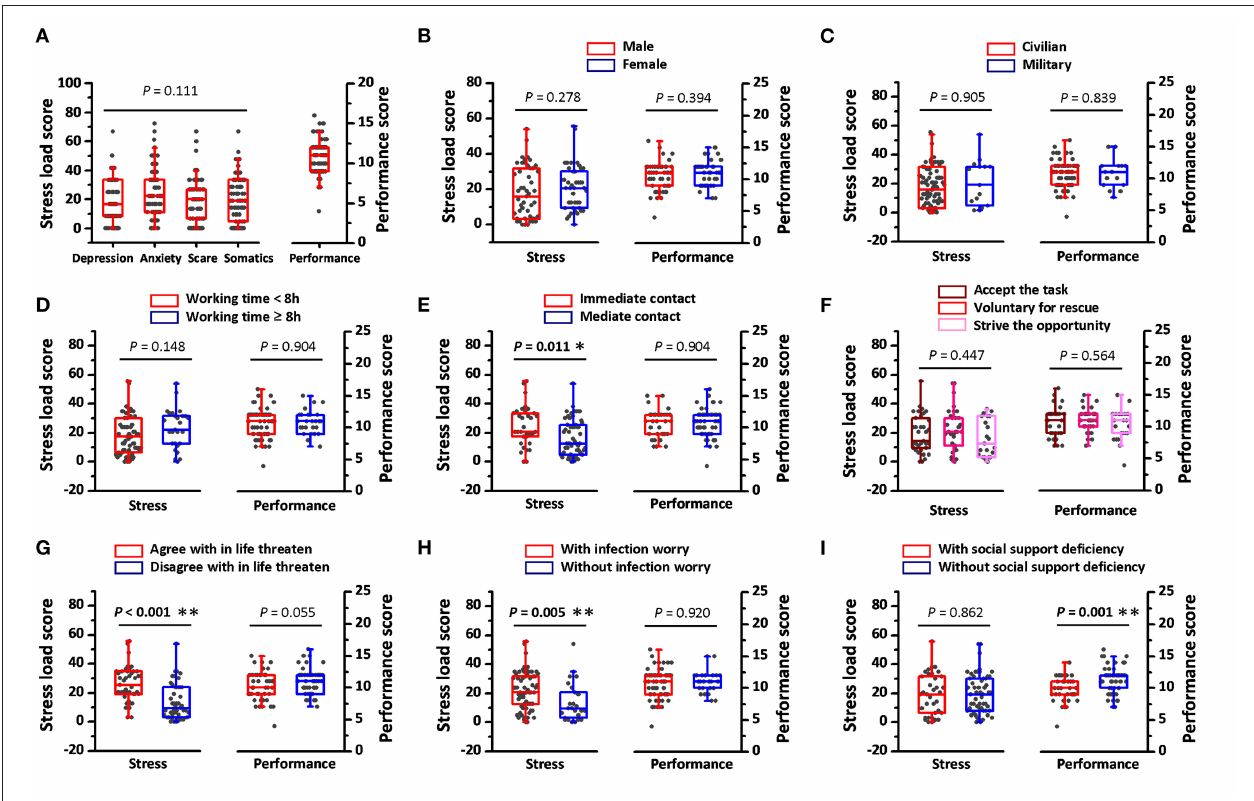
FIGURE 1 | Stress load and working performance assessment in Wuhan medical rescuers. (A) The stress load score of all survey participants in depression, anxiety, scare, and somatic alteration dimensions. The stress load score in each dimension was calculated as a normalized ( × 100 to make it from 0 to 100) ratio between items total scores to possible max scores in the respective dimension. Performance scores, calculated as the summation of four items scores, were also presented to show the performance in all survey participants. (B–I) The stress load scores and performance scores in different genders, identities, working time per day, COVID-19 contacts, motives for joining rescue, subjective views, and social supports. The general stress load scores were calculated as the average among the scores in the four dimensions. Social support deficiency was determined as rescuers receiving < 80% support compared to that before rescue. Horizontal lines across each box represent medians of the stress load score or the performance score, while heights of each box represent interquartile ranges of stress or performance distribution. * P < 0.05, ** P <